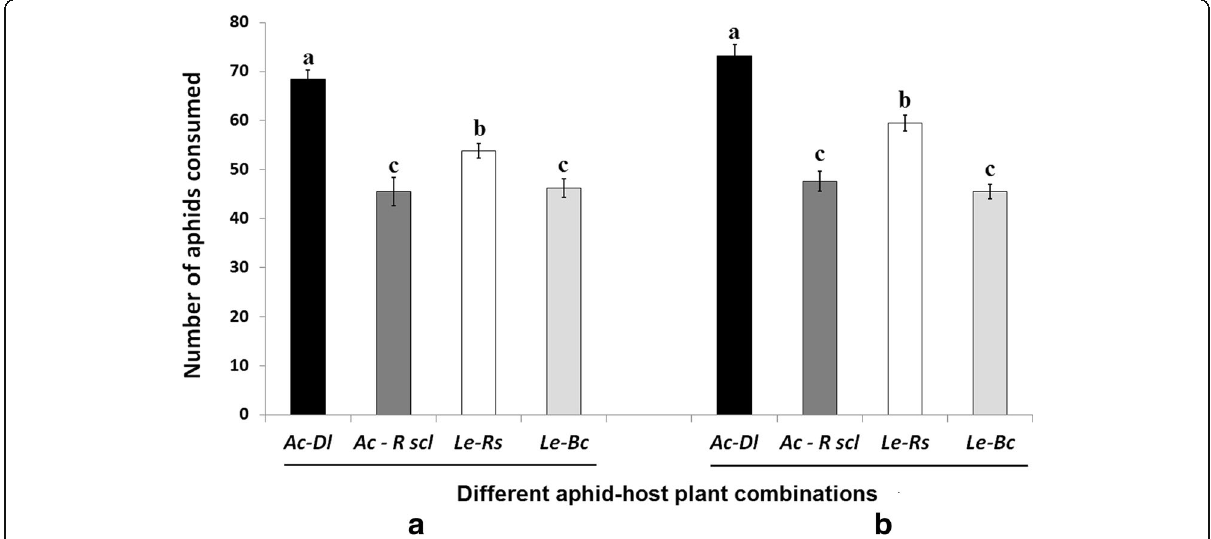
Fig. 1 Number of aphids consumed by adult a male and b female of M . sexmaculatus when fed on different aphid – host plant combinations (i.e., (i) Ac-Dl = A . craccivora – D . lablab , (ii) Ac-R scl = A . craccivora – R . sceleratus , (iii) Le – Rs = L . erysimi – R . sativus , and (iv) Le – Bc = L . erysimi – B . campestris . Error bars denote standard deviation. Bars indicated by the same letter are not statistically different at P < 0.05 (Tukey ’ s